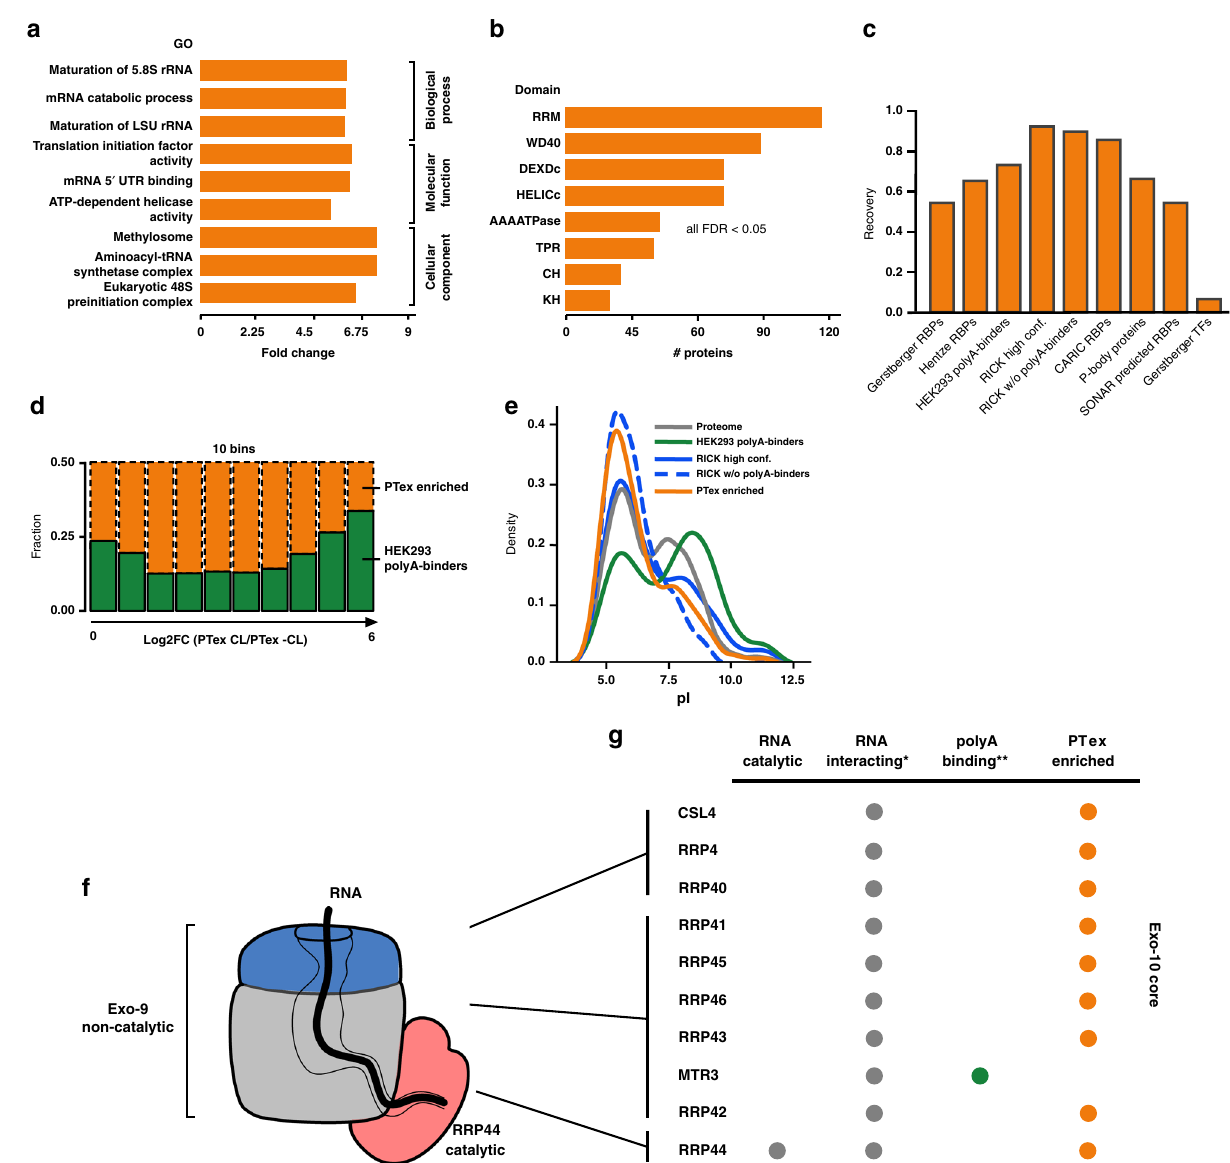
Fig. 6 Features of RNA-interacting proteins found by PTex. a Top 3 enriched GO terms (CC, MF, BP) and b enriched protein domains in PTex-puri fi ed proteins from HEK293 cells; p -value derived from a one-tail Fisher Exact test and FDR determined by the Benjamini – Hochberg method 75 . c PTex-puri fi ed proteins overlap with well-described RBPs but not transcription factors. Recovery of Gerstberger RBPs and transcripiton factors (TFs) reviewed in ref. 29 , a recent review on RBPs by ref. 8 , HEK293 poly-A binders 2 , RBPs found by RNA interactome using click chemistry (RICK; 12 CARIC 13 ), P-body components 39 and a recent prediction of candidate RBPs (SONAR 40 ,). d Distribution of previously identi fi ed HEK293 mRNA-binding proteins (green; 2 ) in PTex; each bin represents 10% of the 3037 PTex proteins from lowest to highest enrichment. e mRNA-binding proteins display a bimodal pI distribution pattern with peaks at pH 5.5 and 9.5 1, 2 . RNA-interactors in general peak at pI 5 – 6 as found by PTex and RICK 12 . Proteins of the RNA exosome are prototype PTex proteins. f The RNA exosome core consists of 10 subunits: nine non-catalytically active proteins (Exo-9) forming a barrel-like structure and an additional RNase (Rrp44; Exo-10); modi fi ed from ref. 41 . g *All exosome subunits are labelled “ RNA-binding ” (Uniprot.org); **green = identi fi ed via poly-A selection in ref. 2; orange = enriched in The upper aqueous phase (Aq1) was carefully removed and transferred to a new Tetracycline (100 μ g/ml) overnight. The following day, 10 colonies per strain were 2 ml tube containing 300 μ l of solution D (5.85 M guanidine isothiocyanate (Roth, picked, resuspended in PBS and streaked on plates containing Ampicillin or 0017.3); 31.1 mM sodium citrate (Roth, 3580.3); 25.6 mM N -lauryosyl-sarcosine Kanamycin (or Tetracycline) and incubated at 37 – 40 °C. Colonies that showed (PanReac AppliChem, A7402.0100); 1% 2-mercaptoethanol (Sigma)). Then, 600 μ l resistance to Kanamycin (or Tetracycline) but not to Ampicillin were selected for neutral phenol and 200 μ l BCP were added, mixed and centrifuged as before. After further analysis, and the correct expression of the epitope tag was veri fi ed by phase separation, the upper 3/4 of Aq2 and the lower 3/4 of Org2 were removed. western blot. The resulting interphase (Int2) was kept in the same tube and mixed with 400 μ l water, 200 μ l ethanol p.a., 400 μ l neutral phenol and 200 μ l BCP (1 min, 21°C, 2000 rpm, Eppendorf ThermoMixer) and centrifuged as previously. Aq3 and Org3 PTex . HEK293 suspensions in 600 μ l of DPBS (5 – 8× 10 6 cells, ±CL) were mixed were carefully removed, while Int3 was precipitated with 9 volumes of ethanol with 200 μ l of each: neutral phenol (Roti-Phenol, Roth 0038.3), toluol (Th.Geyer, ( − 20 °C, 30 min to overnight). Samples were centrifuged during 30min at 752.1000) and 1,3-bromochloropropane (BCP) (Merck, 8.01627.0250) for 1min 20,000× g , pellets dried under the hood for max. 10min and solubilised with 30 μ L (21 °C, 2.000 rpm, Eppendorf ThermoMixer) and centrifuged 20,000× g 3min, 4°C.